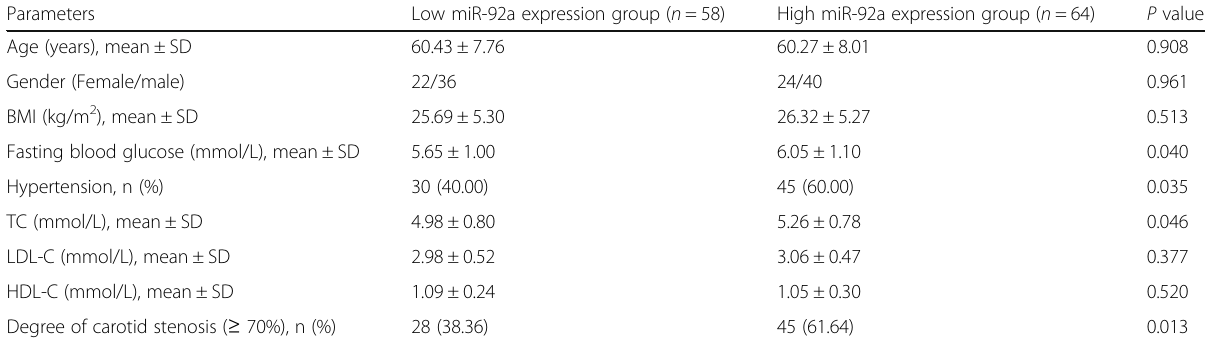
Table 2 Association of miR-92a with the clinical data of ACSA patients Parameters